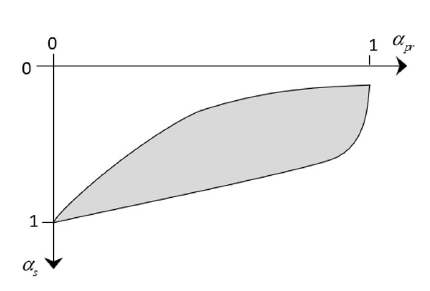
Figure 1. Correlation between settlement reduction coefficient, α s, and load sharing coefficient α pr of piled raft.